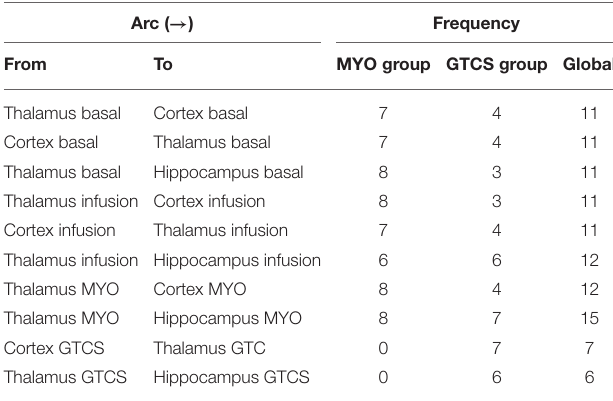
TABLE 1 | The strongest arcs identified in developed Dynamic Bayesian Network.